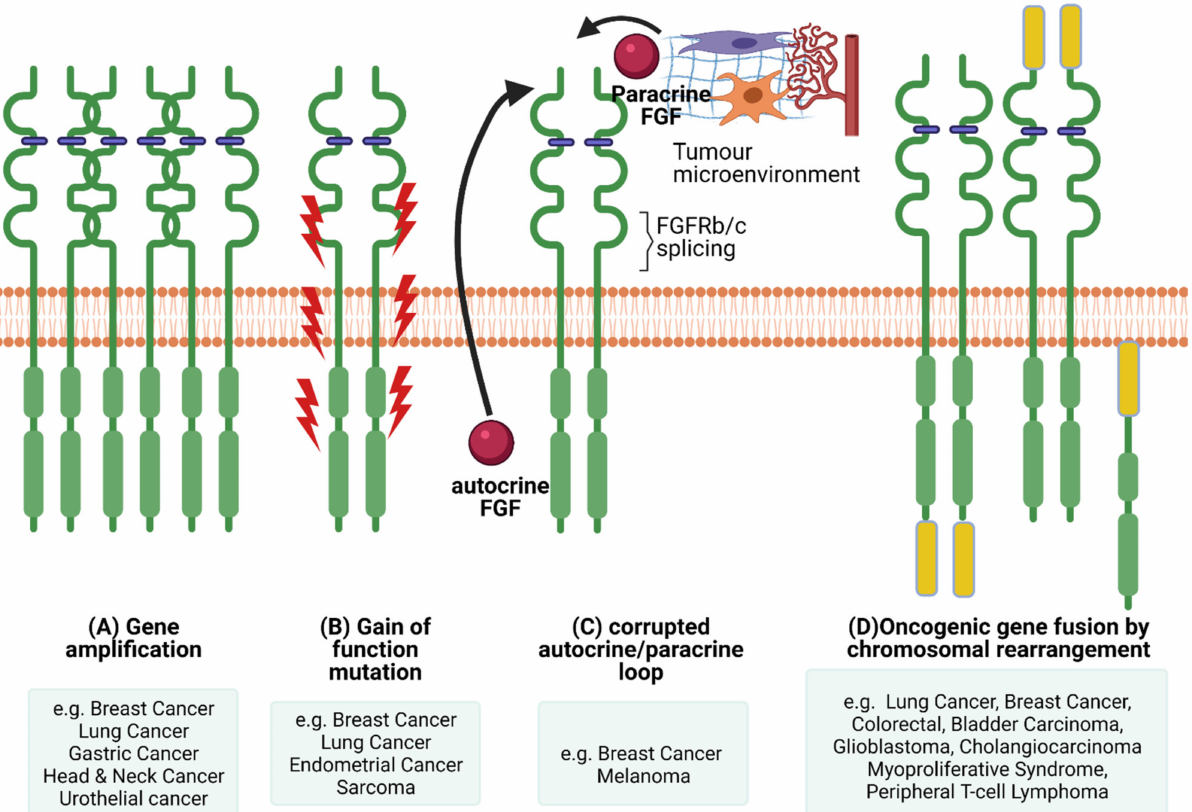
Figure 3. FGFR dysregulations. There are several mechanisms of oncogenic FGFR function. ( A ) Gene amplification results in accumulation of FGFRs that usually translate into protein overexpression and activation of the FGFR axis. ( B ) Gain of function mutations can lead to constitutive FGFR activation with or without FGF binding. ( C ) Corrupted autocrine and paracrine loops, either via alternative splicing affecting ligand binding specificity or FGFRs getting overstimulated by FGFs produced in an autocrine fashion, by the cancer cells themselves, or by the tumour microenvironment, in a paracrine fashion. ( D ) Chromosomal rearrangements can lead to the creation of hybrid oncogenic FGFRs by fusing with binding partners at the carboxyl or amino termini. Created with BioRender.com (accessed on 7 November